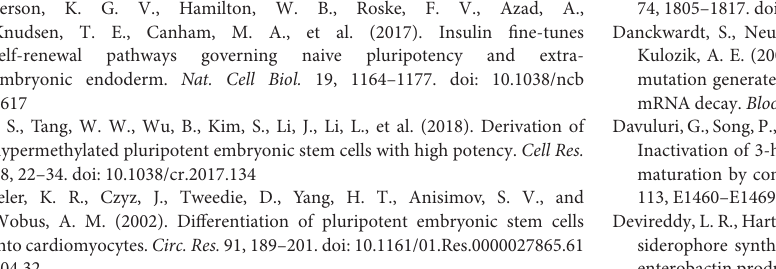
Supplementary Figure 3 | Molecular features of Bdh2 -knockout ASCs. (A) Gene Ontology (GO) analysis of significantly enriched metabolism-related “biological processes” (BP) of the differentially expressed genes (DEGs) for Bdh2-knockout ASCs versus ASCs described in Figure 3A . (B) Heatmap showed up/down-regulated GO-BP terms and KEGG pathways, respectively. (C) Gene Set Enrichment Analysis (GSEA) analysis showing enriched GO-BP terms for up-regulated DEGs and down-regulated DEGs, respectively. (D) Heatmap listed a number of differentially expressed adhesion-related genes in Bdh2-knockout ASCs versus ASCs, enriched in three GO terms, “adhesion junction,” “focal adhesion,” and “gap junction.” Supplementary Figure 4 | Bdh2 knockout regulates DNA methylation in ESCs. (A) Real-time PCR analysis of DNA methyltransferase genes expression ( Dnmt3a , Dnmt3b, and Dnmt3l ) in the Bdh2 -knockout ESCs, ESCs were used as control. Data were obtained in triplicate and presented as mean ± SD. p -values were calculated by two-way ANOVA, * p < 0.05, ** p < 0.01, *** p < 0.001. (B) Western blotting analysis for BDH2, DNMT3A, DNMT3B, DNMT3L, and DNMT1 in two Bdh2 -knockout ESCs. (C) Immunostaining of DNMT3A in Bdh2 -knockout ESCs and ESCs. Scale bars, 50 µ m. Supplementary Figure 5 | Differentiated potency of Bdh2 -knockout ESCs. (A) Real-time PCR analysis of endoderm, mesoderm and ectoderm-associated genes expression in the embryoid bodies of Bdh2 -knockout ESCs, embryoid bodies of ESCs were used as control. Data were obtained in triplicate and presented as mean ± SD. p values were calculated by two-way ANOVA, * p < 0.05, ** p < 0.001, *** p < 0.0001. (B) Morphology of embryoid bodies induction by Bdh2 -knockout ASCs and ASCs in Day2, Day3, Day5, and Day7. Scale bars, 100 µ m. (C) Morphology of embryoid bodies induction by Bdh2 -knockout ESCs and ESCs in Day1 ∼ Day7. Scale bars, 100 µ m. (D) Statistics of the number and diameter of embryoid bodies formed by Bdh2 -knockout ESCs and ESCs, respectively. N, represents the number of EB spheres. (E) Real-time PCR analysis of apoptotic and autophagy-associated genes expression in the embryoid bodies of Bdh2 -knockout ESCs, embryoid bodies of ESCs were used as control. Data were obtained in triplicate and presented as mean ± SD. p -values were calculated by two-way ANOVA, * p < 0.05, ** p < 0.001, *** p < 0.0001. (F) Representative bright-field images from Bdh2 -knockout ESCs and ESCs differentiated for 5 days toward the primitive endoderm lineage. Scale bars, 50 µ m. (G) Real-time PCR analysis of key markers after 4/5/6 days of directed differentiation toward primitive endoderm. Data were obtained in triplicate and presented as mean ± SD. p -values were calculated by two-way ANOVA, * p < 0.05, ** p < 0.001, *** p <